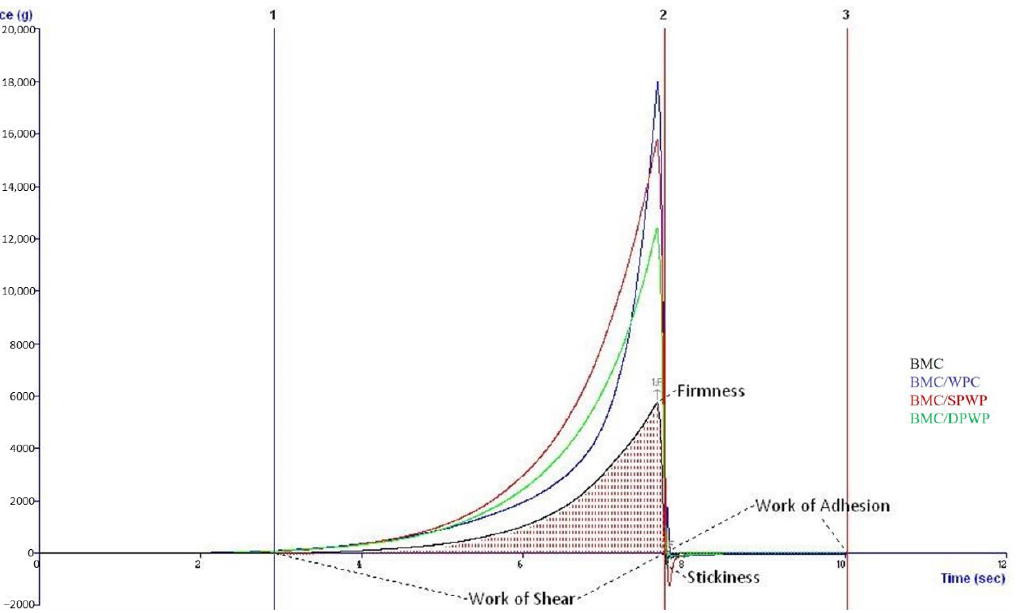
Figure 2. Texture of buttermilk cheeses with polymerized whey protein. BMC, BMC/WPC, BMC/SPWP, BMP/DPWP: the same at Table 1.